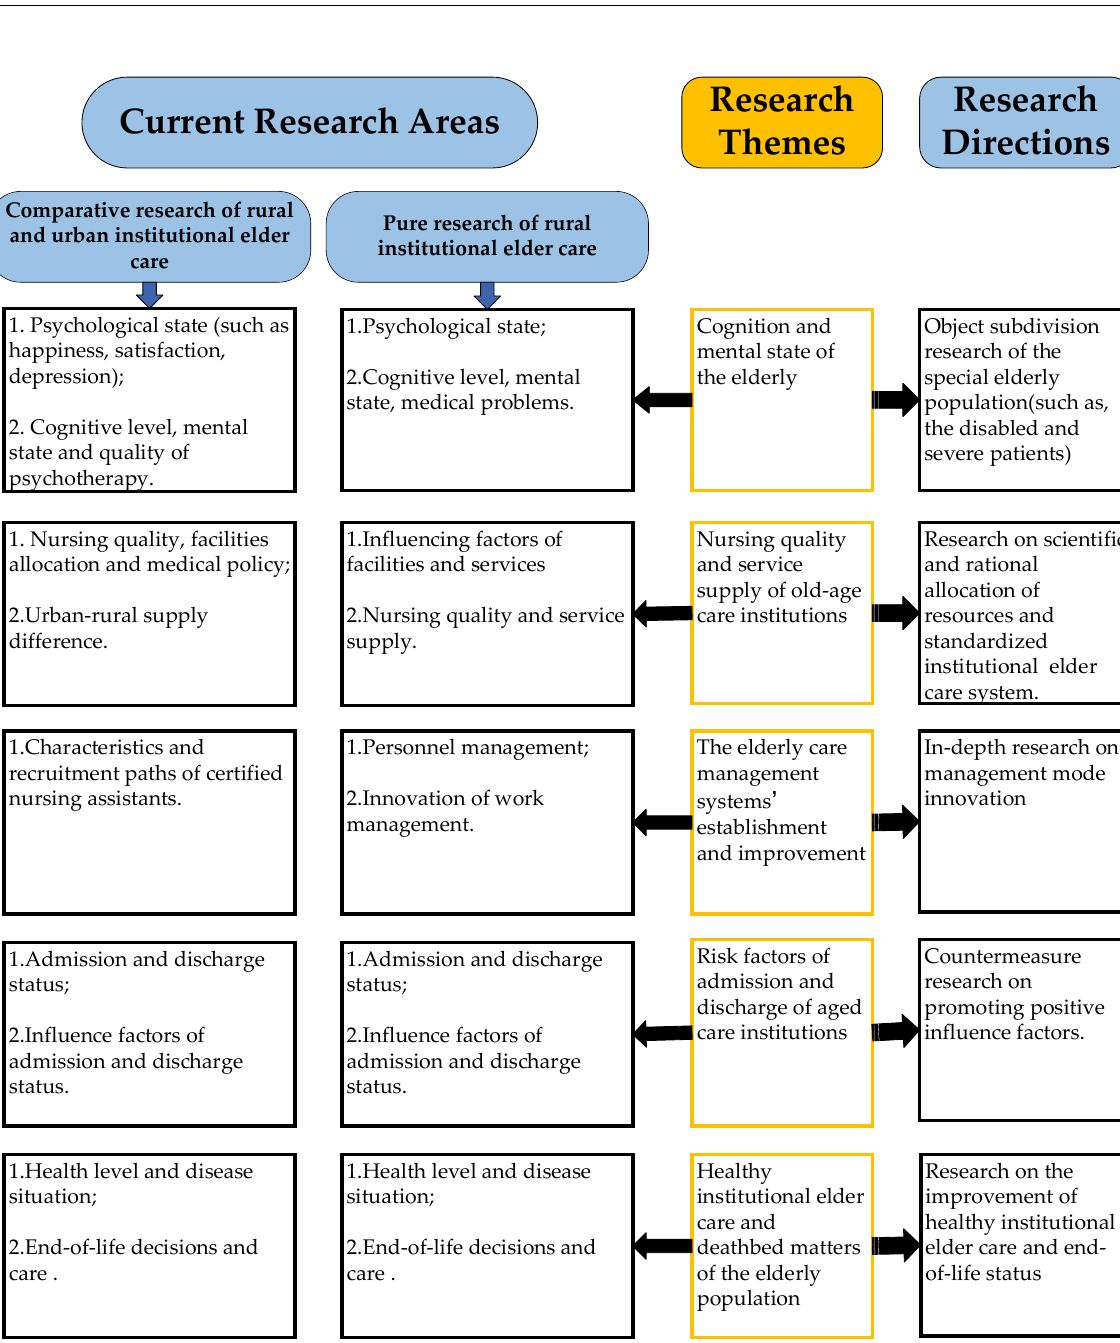
Figure 9. Framework linking current research topics to future research directions.